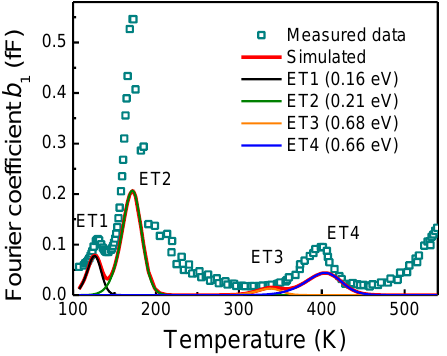
(b) Figure 4. Impact of repetitive UIS on switching performance of the power SiC TrenchMOS. ( a ) Turn- on and ( b ) turn-off the process. A significant increase in turn-on time was observed after 10 million UIS pulses. No impact on the turn-off process was observed. Open symbols mean the values corre- spond to virgin samples, while the filled symbols represent the measurement after 10 million UIS pulses. 4. Defect Analysis